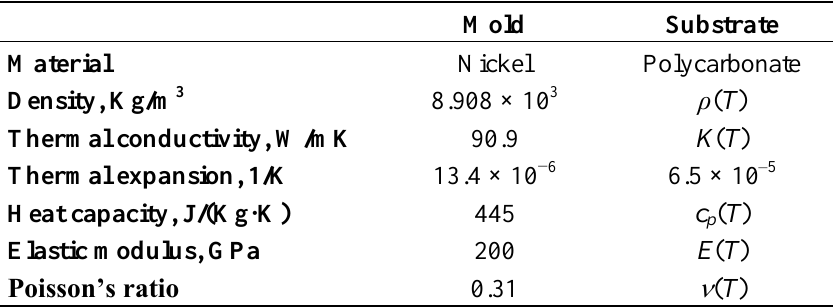
Table 1. Material properties of the mold and